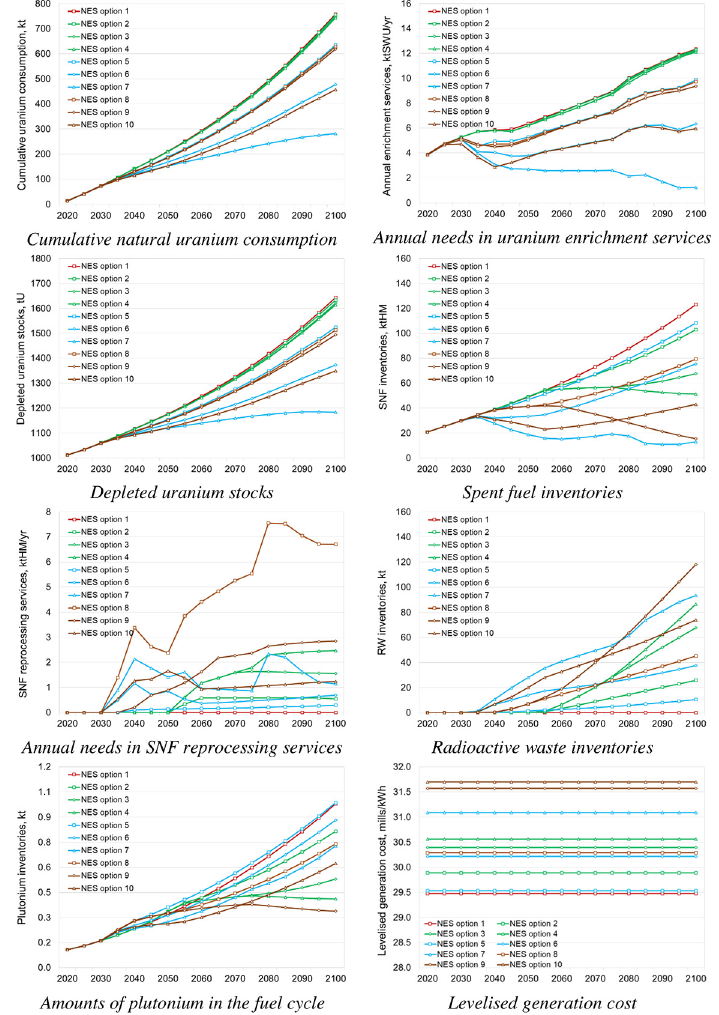
Fig. 4. Material fl ows and needs for fuel cycle